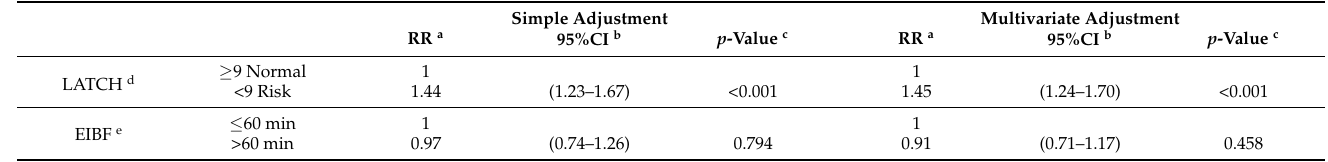
Table 4. Multivariate analysis of abandoning exclusive breastfeeding at 6 months